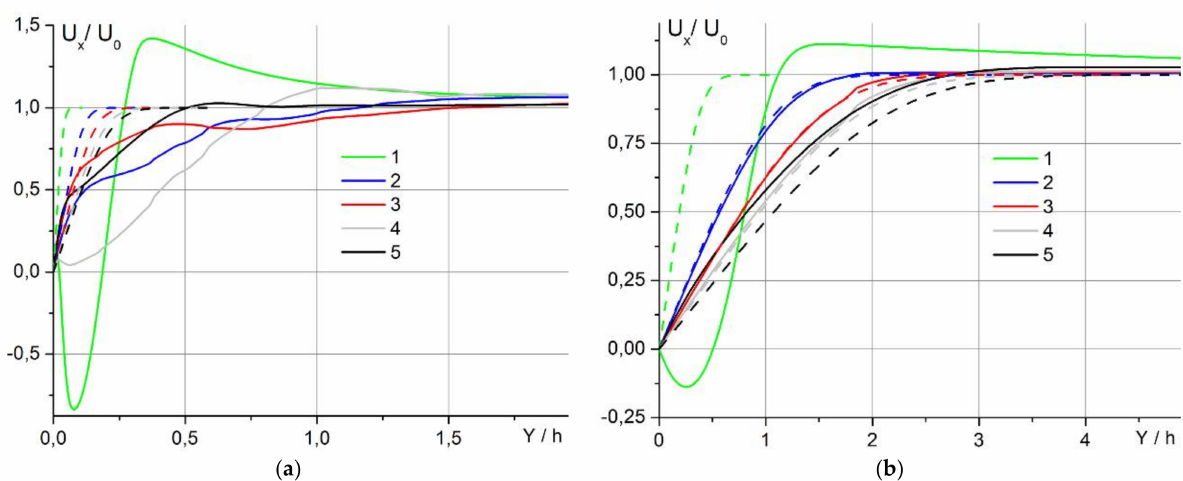
Figure 18. Instantaneous profiles of the horizontal velocity component at different distances from the leading edge of a horizontal plate in potentially homogeneous fluid ( N = 10 − 5 s − 1 , L = 10 cm, U = 80 cm/s); ( a , b ) h = 0.5, 0.05 cm, curves 1–5 x / L = 0.03, 0.25, 0.5, 0.75, 0.97, dotted curves are the Blasius solution